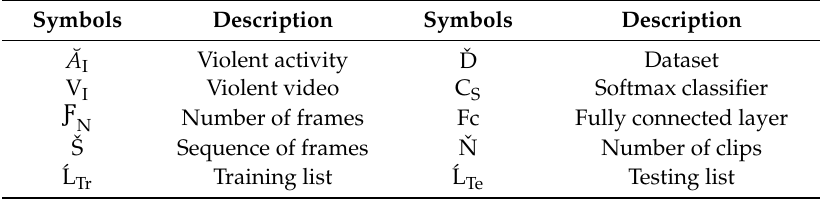
Figure 1. The framework of the proposed violent detection method. In the first phase, a video stream from a surveillance camera is acquired in which persons are detected. The second phase extracts deep features by feeding a selected sequence of frames to a 3D CNN model which detects the violent activity. Lastly, if a violent activity is detected, then we report this information to the nearest station to take immediate action before any injury or disaster occurs. Table 1. Description of the input and output parameters used in the proposed method.